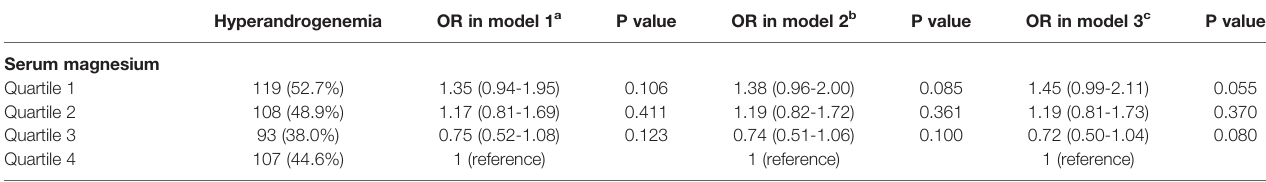
TABLE 5 | Association between hyperandrogenemia and serum magnesium according to quartiles by logistic